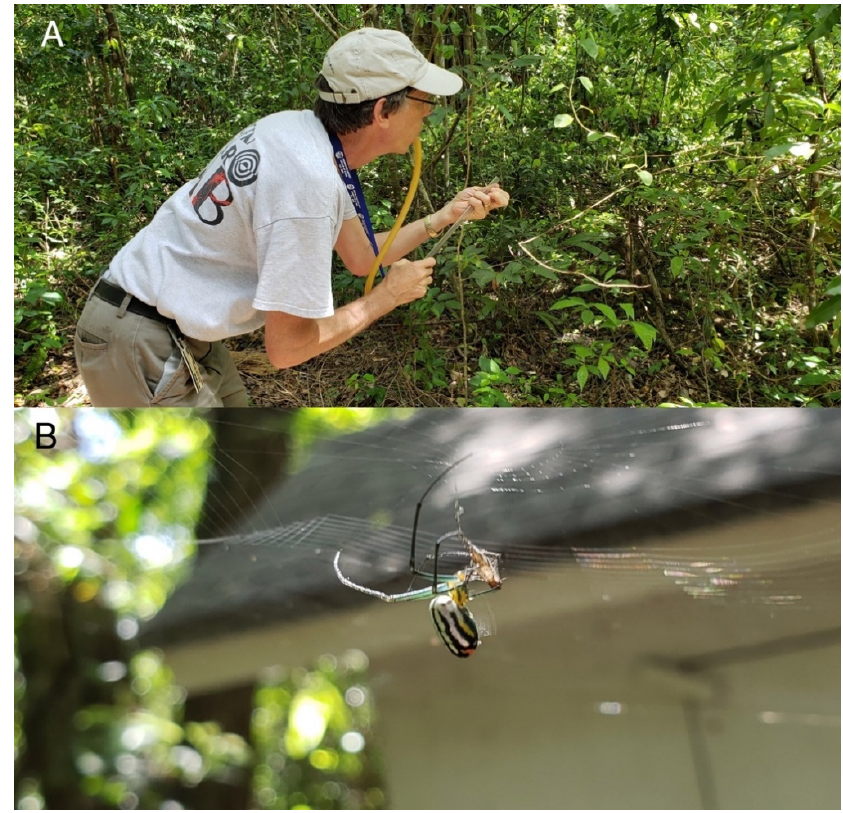
Figure 1. ( A ) In the mosquito handling procedure, mosquitoes were propelled toward the web with a light puff of air, being careful not to blow air directly at the spider. ( B ) An adult female L. argyrobapta subdues a mosquito ( W. vanduzeei ) that had been propelled into the web.